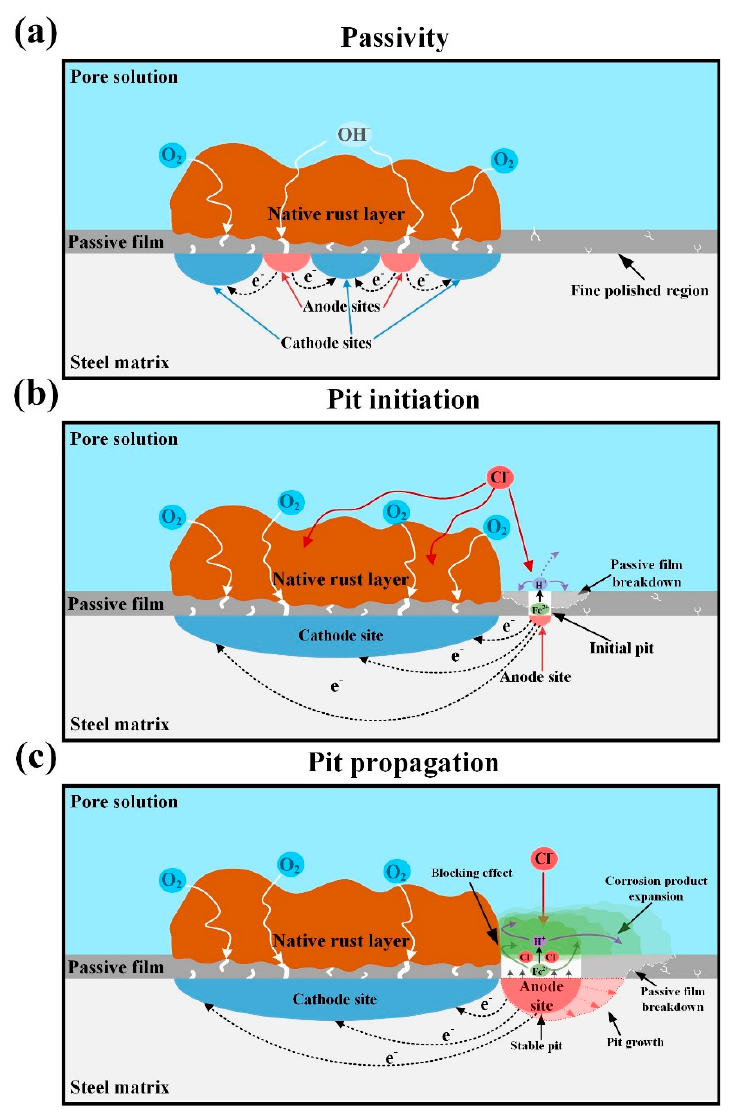
Figure 11. Schematic of the ( a ) passivity of pre-rusted rebar in carbonated SCPS, ( b ) pit initiation and ( c ) pit propagation after chloride ions are introduced.